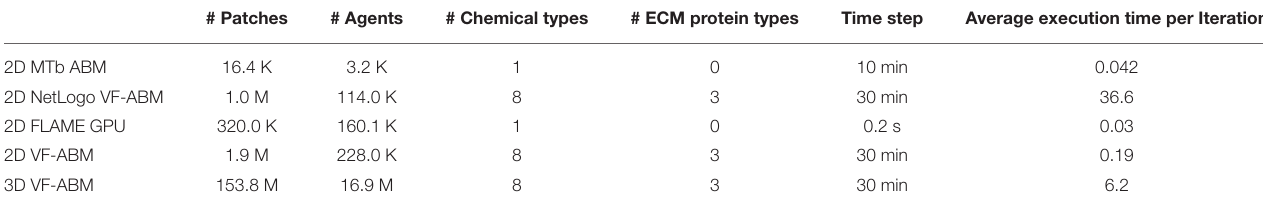
TABLE 5 | Performance and scale comparison with existing high-performance ABM work of similar nature. # Patches # Agents # Chemical types # ECM protein types Time step Average execution time per